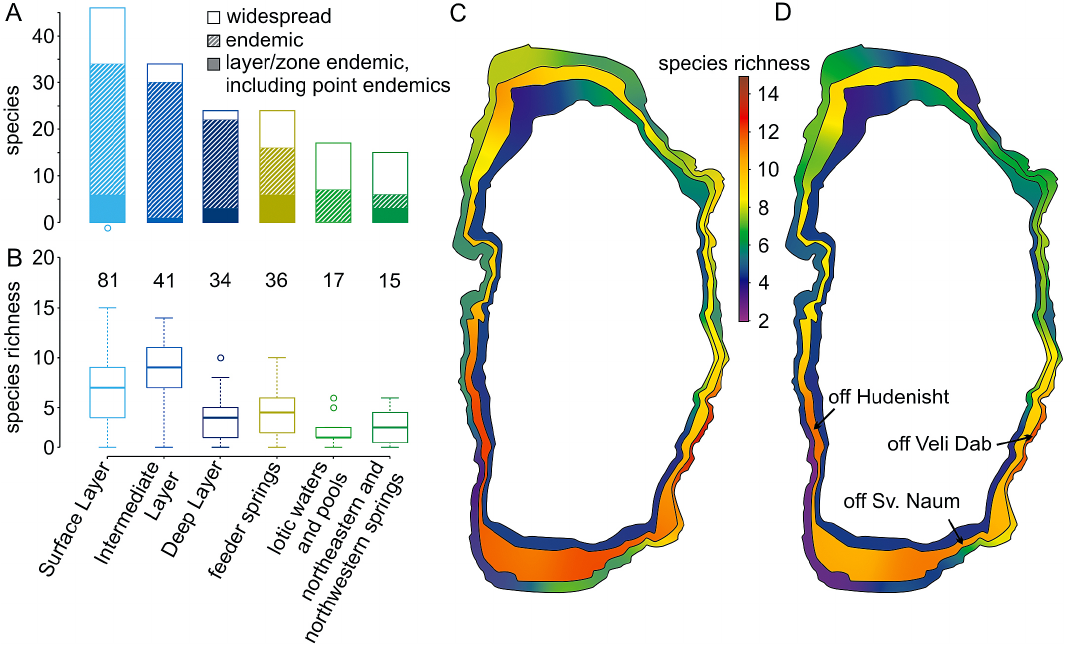
Fig. 4. Zonation and layer-specific analyses of gastropod species richnesses in the Ohrid Basin. (A) Bar plots of species compositions. (B) Quartile box plots of species richness including median, upper and lower quartiles (boxes) and 1.5 interquartile range whiskers (numbers above plots indicate the total number of species in the respective layer/zone). (C) Species richness map based on all species. (D) Species richness map based on endemics. Candidate hotspots of endemic species richness are indicated by arrows. Because of the strong slope at the eastern and western tectonic faults, the depth layers could have a width of less than 10m, and were thus stretched for better